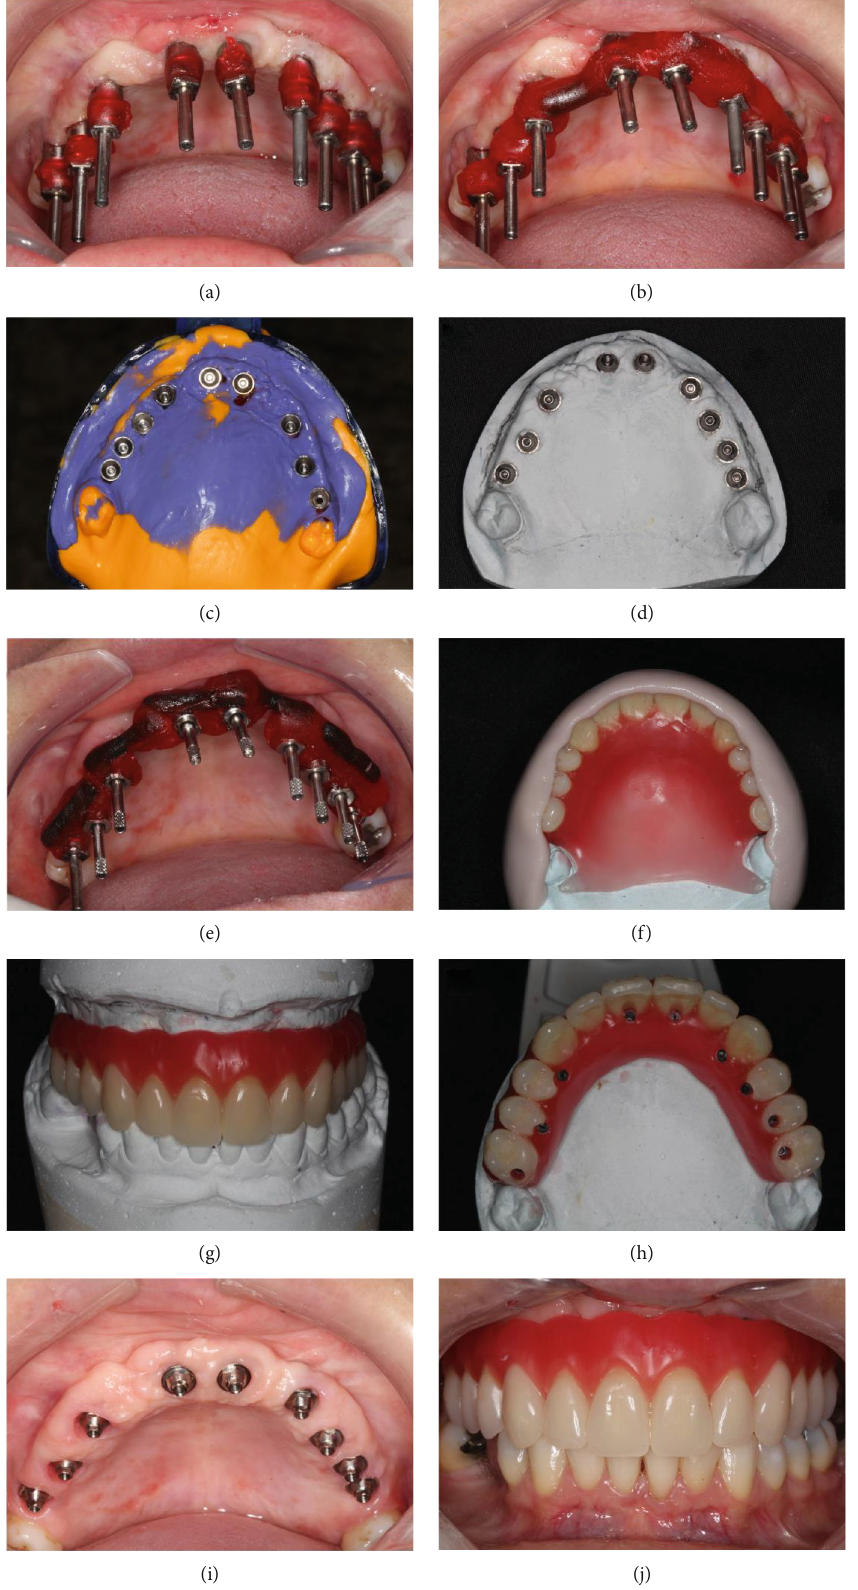
Figure 9: Prosthetic procedures to manufacture the de fi nitive prosthesis were performed. All the necessary steps to create the de fi nitive prosthesis were carried out (a –